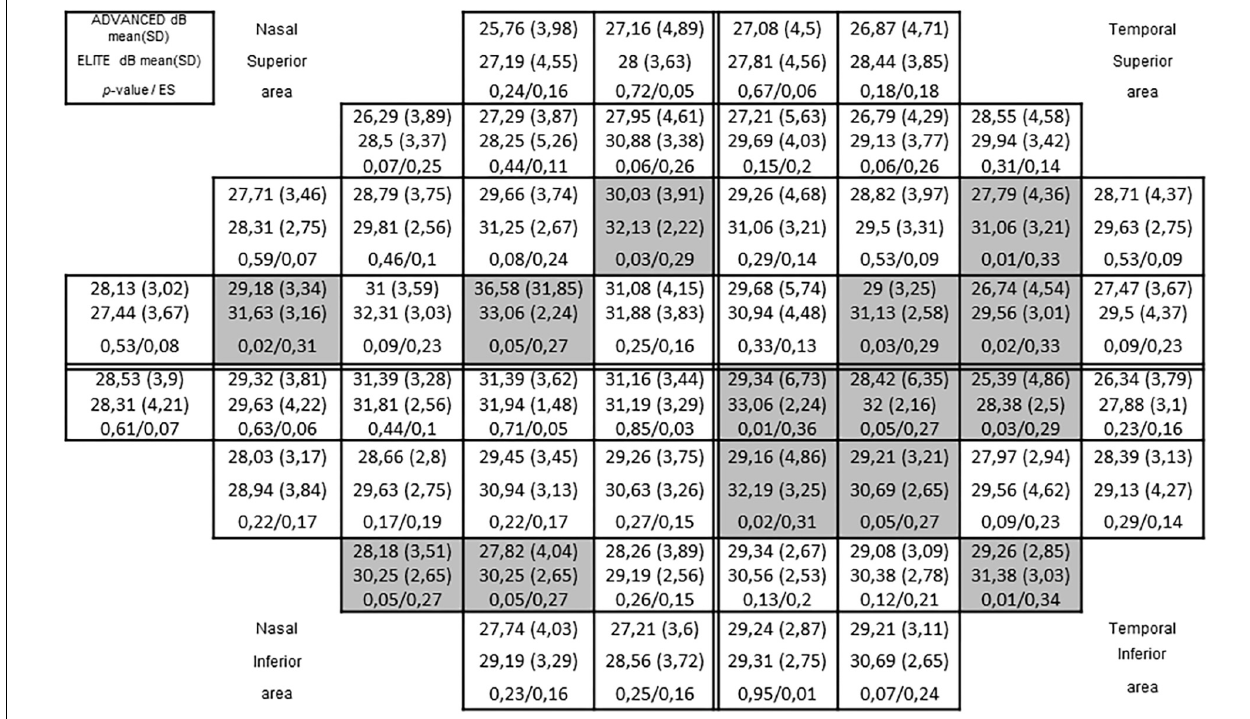
Frontiers in Psychology |